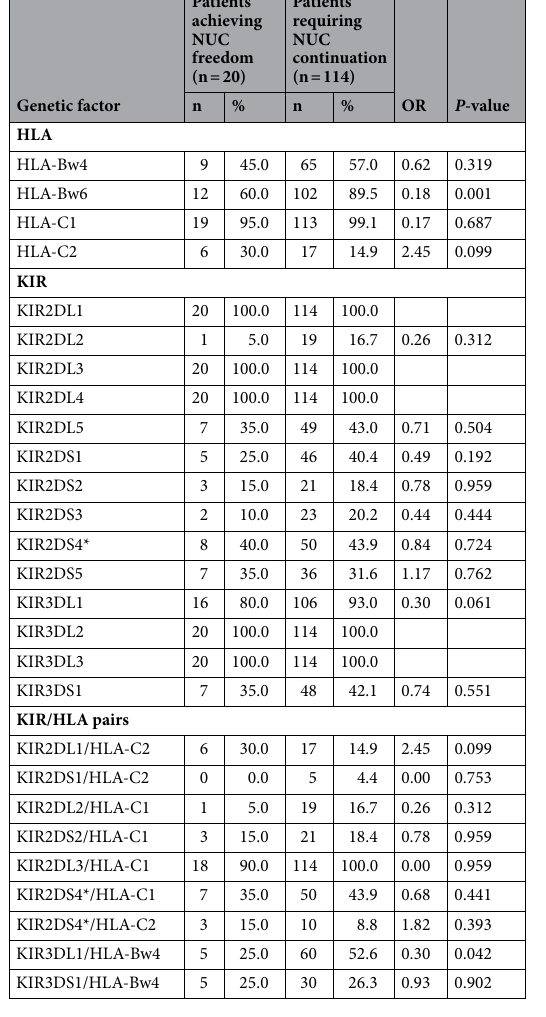
Table 6. Frequency of HLA alleles, KIR genes, and KIR/HLA pairs in patients receiving NUC treatment. HLA human leukocyte antigen, KIR killer immunoglobulin-like receptor, NUC nucleot(s)ide analogue, OR odds ratio. *Full-length KIR2DS4 was genotyped.